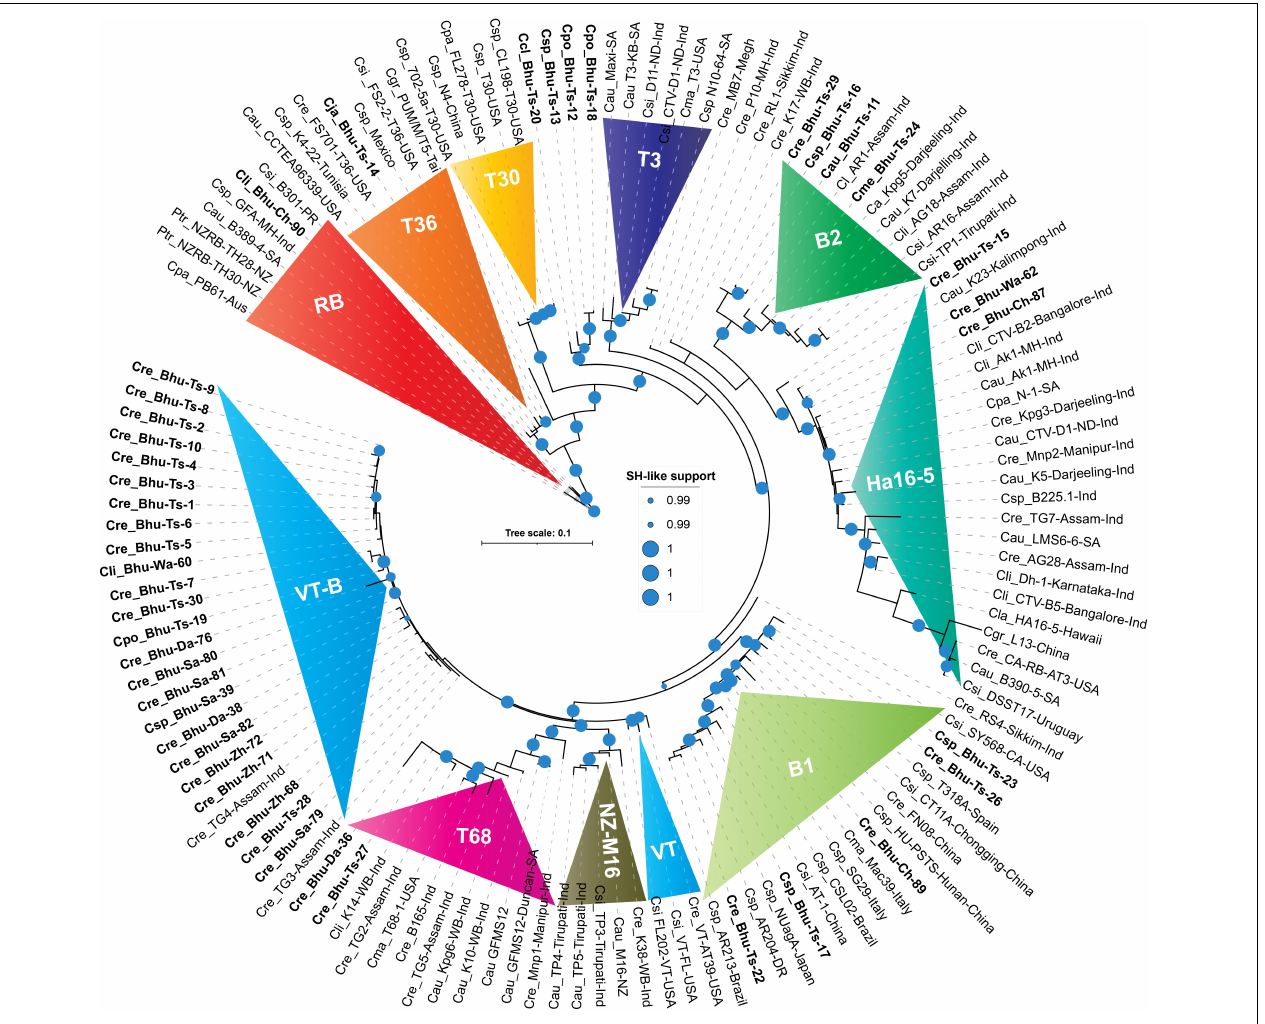
FIGURE 4 | Phylogenetic trees reconstructed using concatenated DNA correspond to four genomic locations showing unprecedented diversities among Bhutanese CTV variants. Maximum likelihood (ML) tree was reconstructed using PHYML3.2.2 (Guindon et al., 2010) with default parameters, except for the model parameter that was set to GTR, and both NNI (nearest-neighbor interchange) and SPR (sub-tree pruning and re-grafting) moves were adopted for their accuracy of branch placement along the tree (Hordijk and Gascuel, 2005). SH-like (Anisimova et al., 2011) support, which is known to outperform bootstrap support (Simmons and Norton, 2014), was used for branch stability. SH-like support of 99% or higher is shown with a cyan color circle. CTV strains were earlier classified under seven (T30, T36, VT, T3, T68, RB, and HA16-5) subtypes or variants (Harper, 2013). In contrast, our concatenated nucleotides-based ML tree showing an additional two (B1 and B2) clades could be confidently allotted with a high SH-like support value. Clades B1 and B2 are named after the Bhutanese variants. Labeling the ML tree was made clearer by using the first letter of the genus and two letters of the citrus species, followed by the isolate or genotype name, place, and the country where it was reported. For clarity, Bhutanese isolates are shown in bold font. For a complete list of the GenBank accessions, species name, isolate or variants name, country name, protein-coding region, and their respective DNA used to build this tree refer to Supplementary Excel File 1 , and for the complete list of Bhutanese isolates, refer to Tables 1 , 3